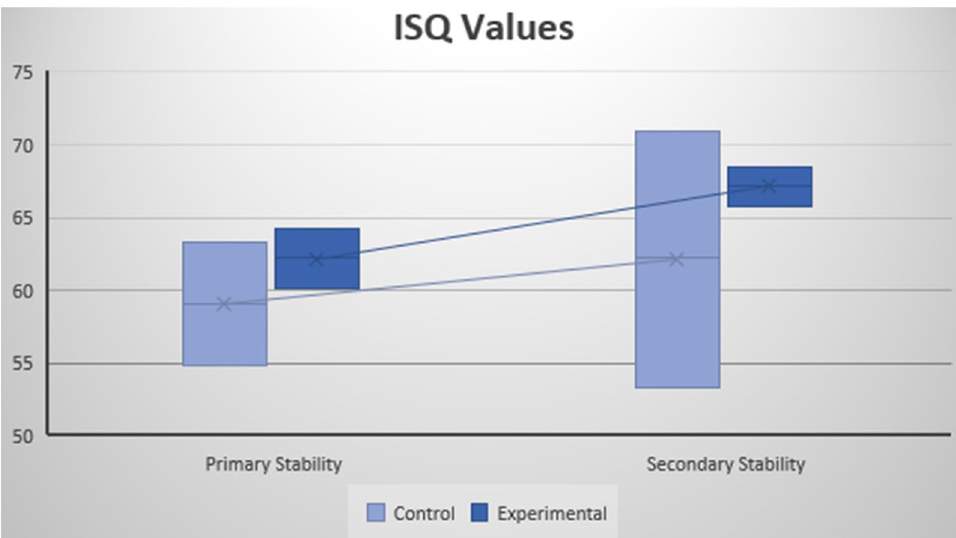
Figure 5. Mean and C.I. of ISQ values for the control group and experimental group during implant insertion (primary stability) and at three months after implant insertion (secondary stability).